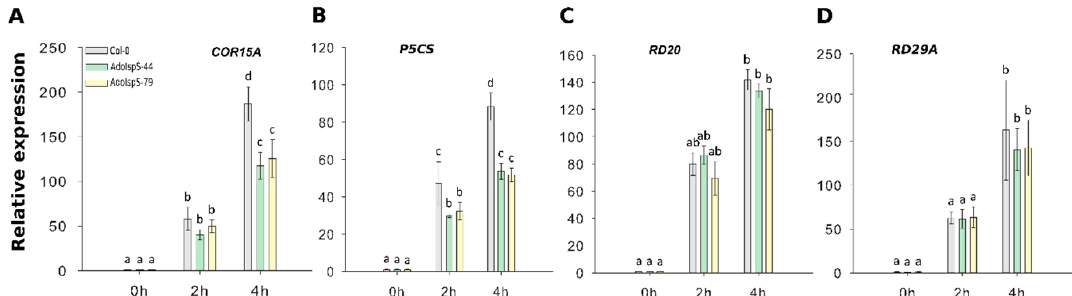
Figure 7. Expression of drought-responsive genes following dehydration stress. ( A – D ) qRT–PCR analysis of drought-inducible genes in IspS transgenic plants in response to dehydration at different time-points. Histogram bars marked with the same letter do not significantly differ from each other (Tukey–Kramer test, p > 0.05). Line bars represent the SD of the means.